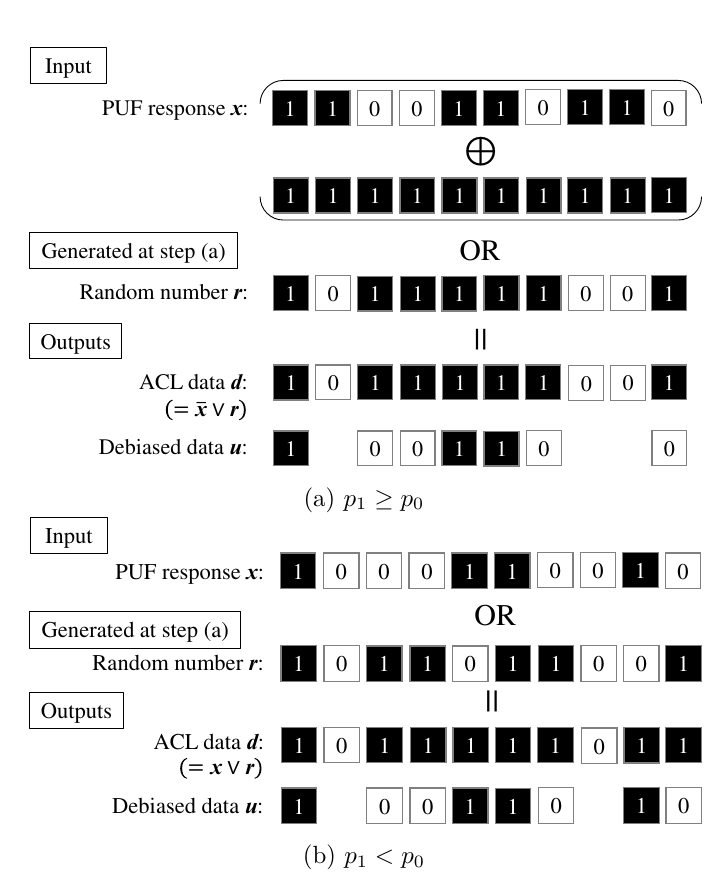
Figure 8: Example of RRS